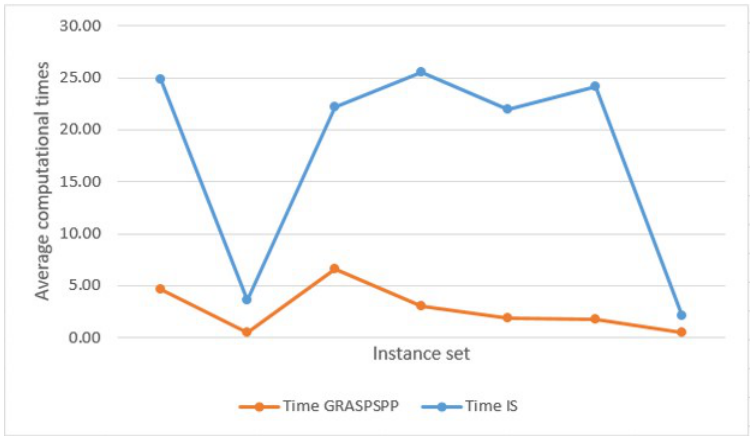
Figure 9. Time comparison between GRASPSPP and IS